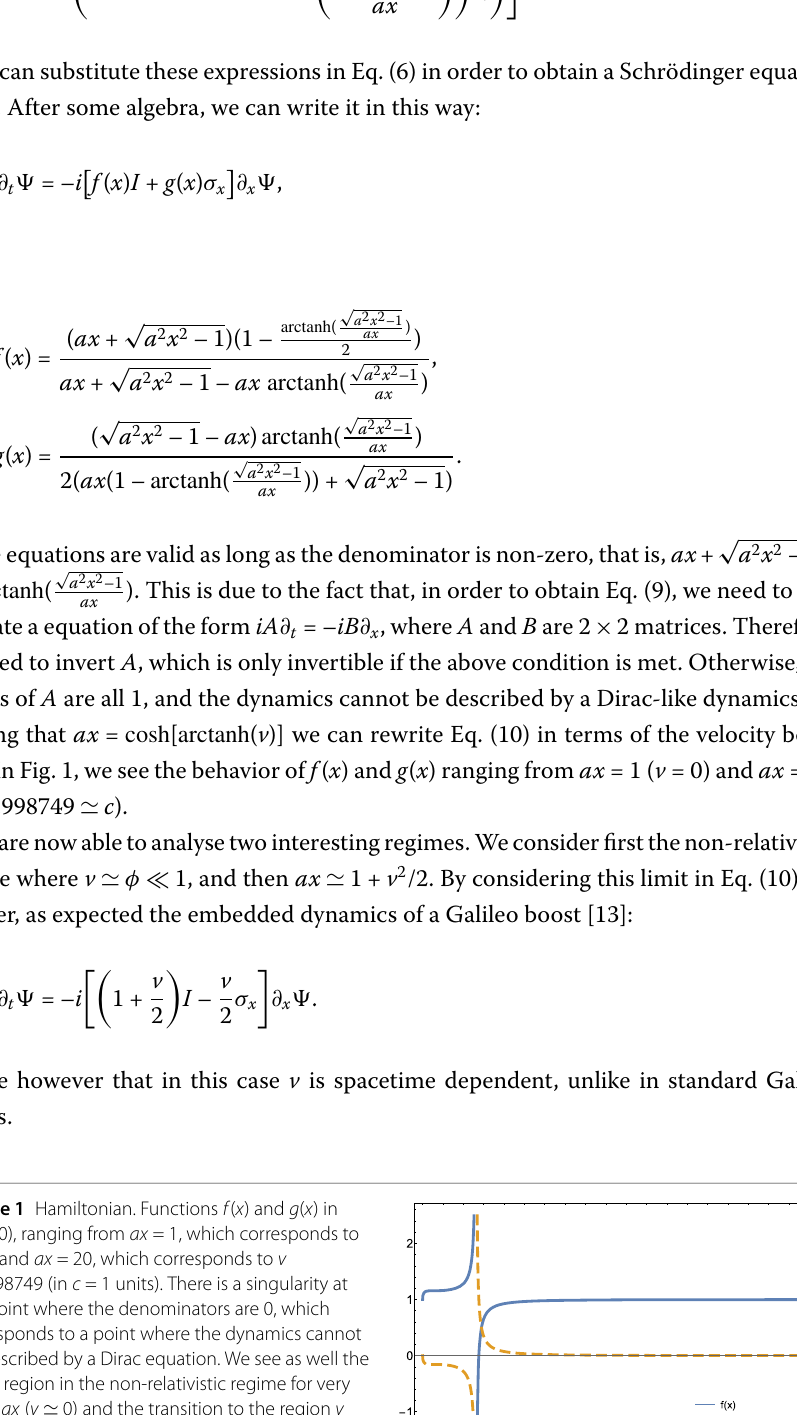
Figure 1 Hamiltonian. Functions f ( x ) and g ( x ) in Eq. (10), ranging from ax = 1, which corresponds to v = 0 and ax = 20, which corresponds to v = 0.998749 (in c = 1 units). There is a singularity at the point where the denominators are 0, which corresponds to a point where the dynamics cannot be described by a Dirac equation. We see as well the linear region in the non-relativistic regime for very small ax ( v (cid:7) 0) and the transition to the region v = 1 ( ax → ∞ ), where the dynamics is equivalent